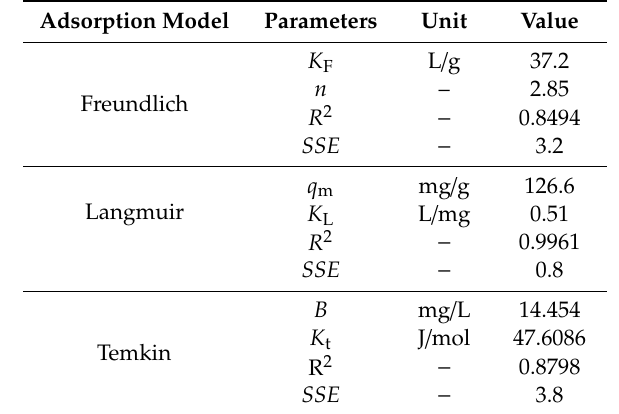
Figure 9. Sorption of Cd onto poultry ash: ( a ) q exp vs. initial Cd concentration, ( b ) q exp vs. equilibrium Cd concentration and ( c ) separation factor (RL) vs. initial Cd concentration. Table 2. Comparison of adsorption isotherm parameters for Cd adsorption onto poultry ash (ash dosage = 5 g / L, adsorption time = 24 h, pH = 5).